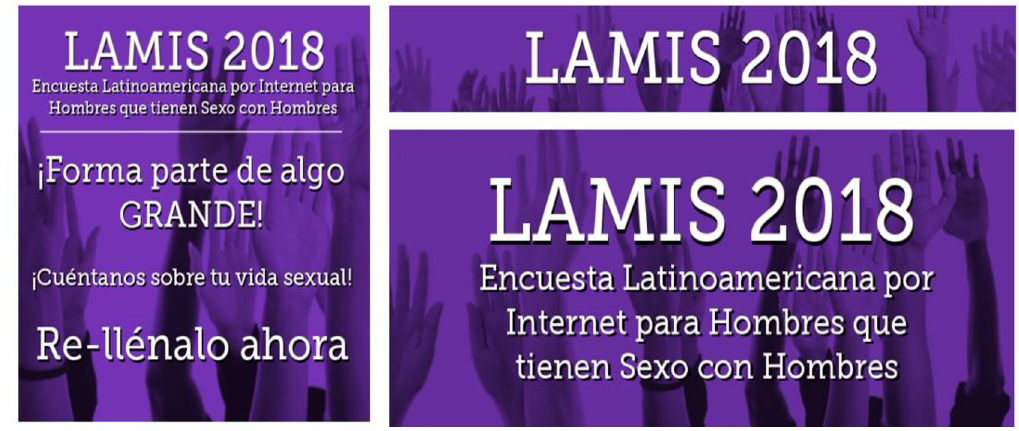
Fig 1. Examples of banners for the promotion of the LAMIS-18